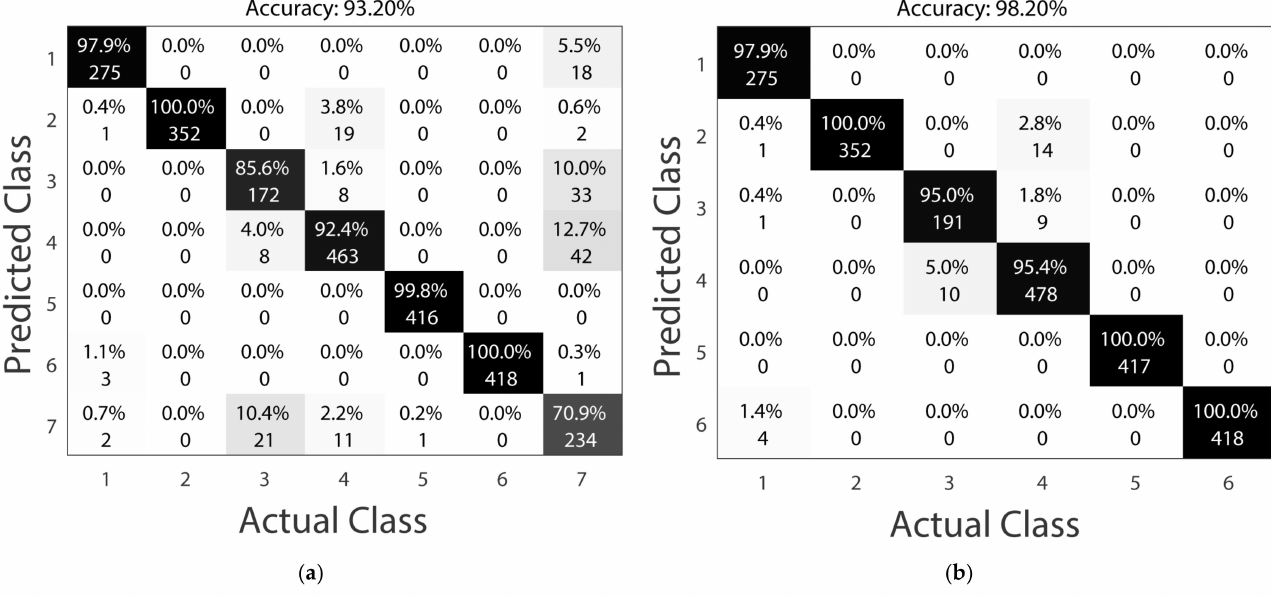
Figure 12. Results of line selection for all available cases ( a ) and only for cases where arc fault did not occur on location 7 (main power line) ( b